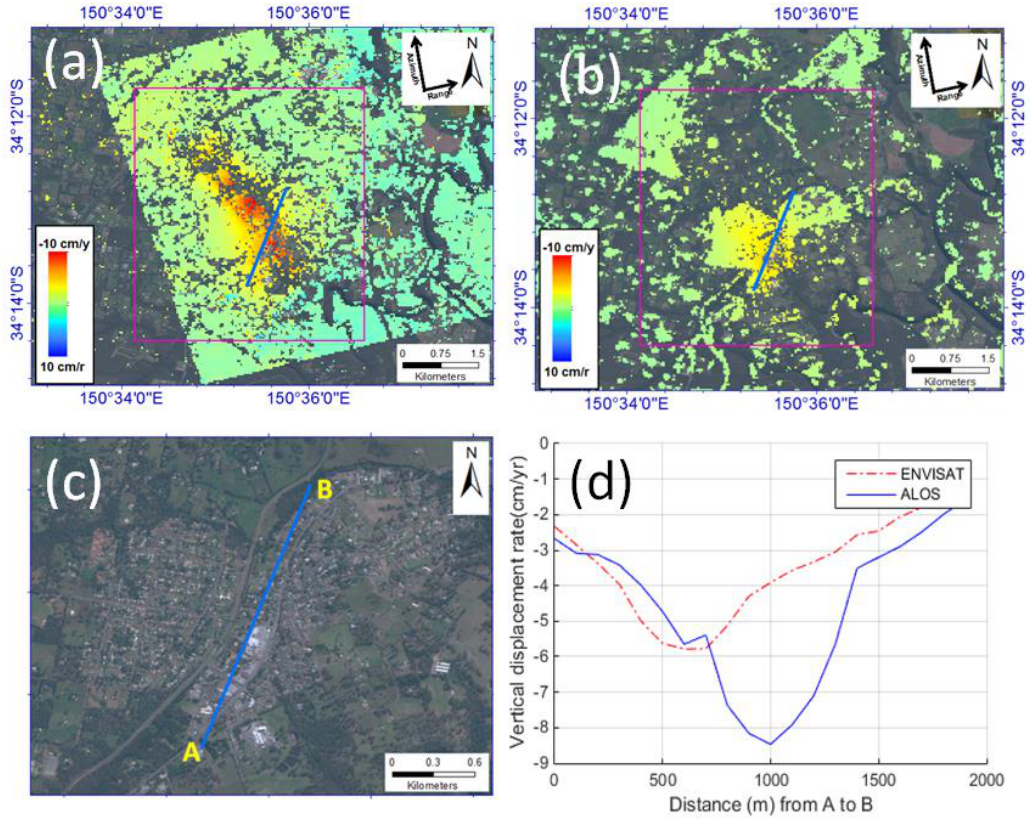
Figure 5. ( a ) L-band and ( b ) C-band measurements over Tahmoor region, the resolution of each pixel is 30 m × 30 m ( c ) Google map over Tahmoor town (© Google Earth) ( d ) the profile line through Tahmoor town.